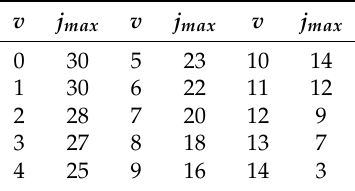
Table 1. Maximum number of rotational states, j max , for each vibrational level of the H 2 ( X 1 Σ + g ) molecule.